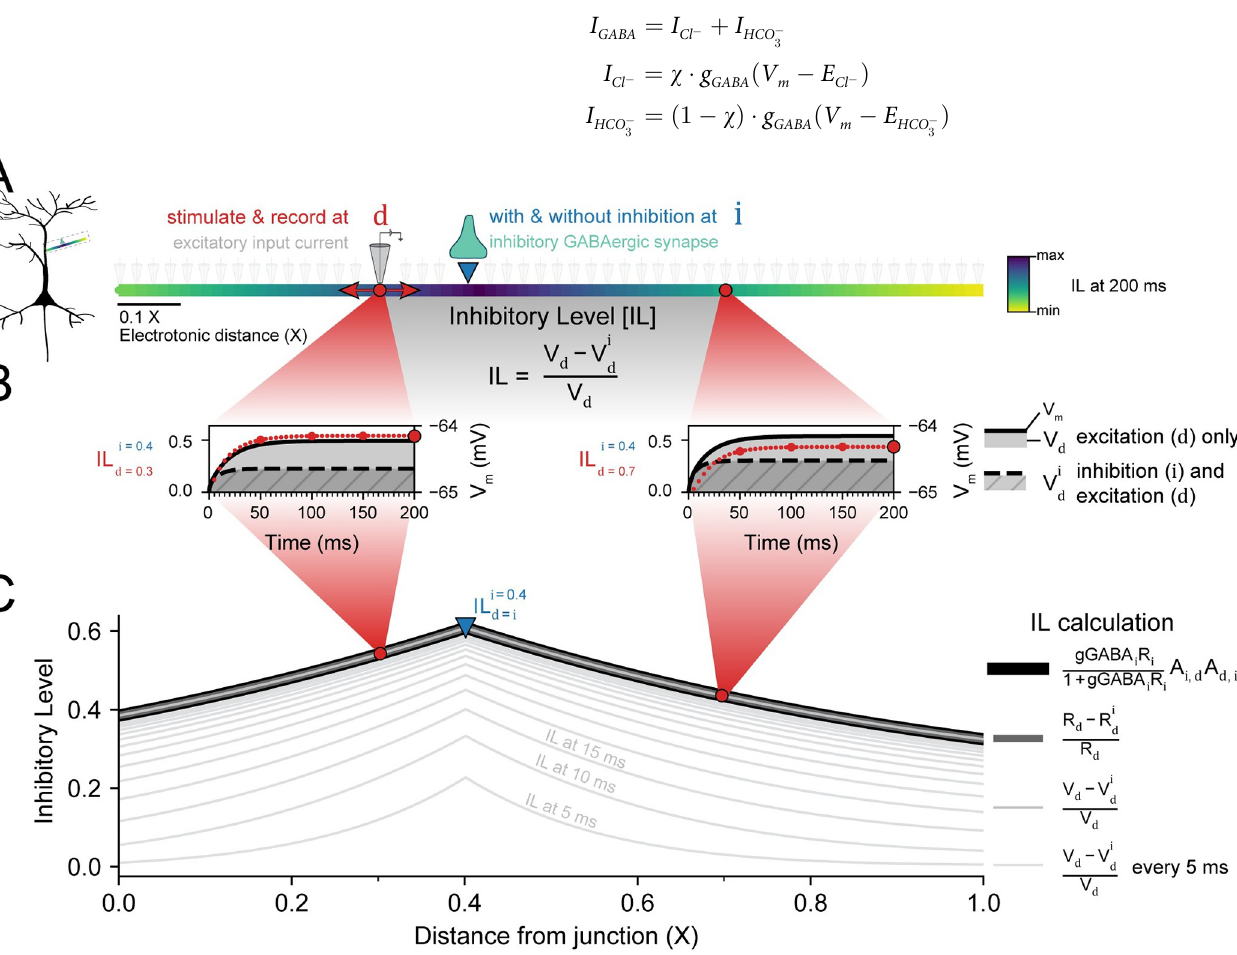
Fig 1. Inhibitory Level (IL) as a metric to assess the local efficacy of dendritic inhibition. (A) The effect that an inhibitory synapse at location i (downward triangle) has on an excitatory input current at location d (circle) is termed the Inhibitory Level (IL). The IL at each location d, for stationary i at 0.4 X, is shown for the full length of the dendrite. (B) The IL is calculated by recording the membrane potential with only excitation at d (solid black line) or excitation at d and inhibition at i (dashed black line). The relative difference in the deflection of the membrane potential from rest, between V d (without inhibition; shaded area) and V di (with inhibition; striped shaded area), is the IL (circles). IL with an integration time window Δ t of 5 ms for d = 0.3 X (left, red circles) or d = 0.7 X (right, red circles) shows that the steady-state IL is reached within 150 ms. Small circles are IL every 5 ms. Bigger circles are every 50 ms. (C) For shunting inhibition, and given sufficient duration, the numerical calculation of IL (thin light grey line) matches the semi-analytical (medium thickness grey line) and analytical (thickest, black line) solutions. The inhibitory synapse was modelled as a fluctuating GABA A conductance, h g i = 0.001 μ S, σ 2 = 0.1 × h g i , and the excitatory input as a constant current, 0.001 nA. C m = 1 μ F � cm -2 , L = 707 μ m, r = 1.0 μ m, R m = 10 M O � cm -2 , and R axial = 0.1 M O � cm -1 .